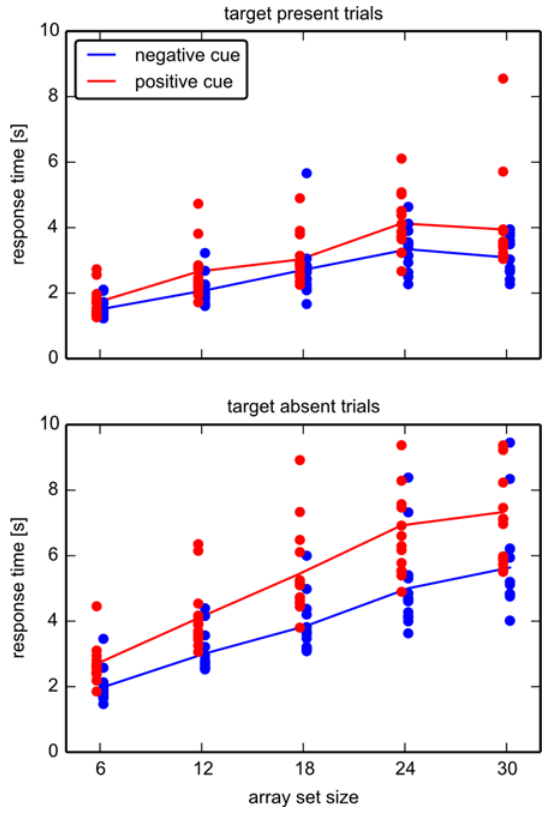
Fig 4. Response Times in experiment 1. Shown are the response times in target present trials (top) and target absent trials (bottom) in both cue types; positive (blue) and negative (red). Dots denote mean values for correct answers of each individual and number of items, lines the means for each group. The slopes of linear fits were determined for target absent trials for set sizes 6 – 24, where linearity seems to be satisfied. All participants exhibited a higher slope in “ negative cue ” (mean value 236ms/item) versus “ positive cue ” (mean value 158ms/item)